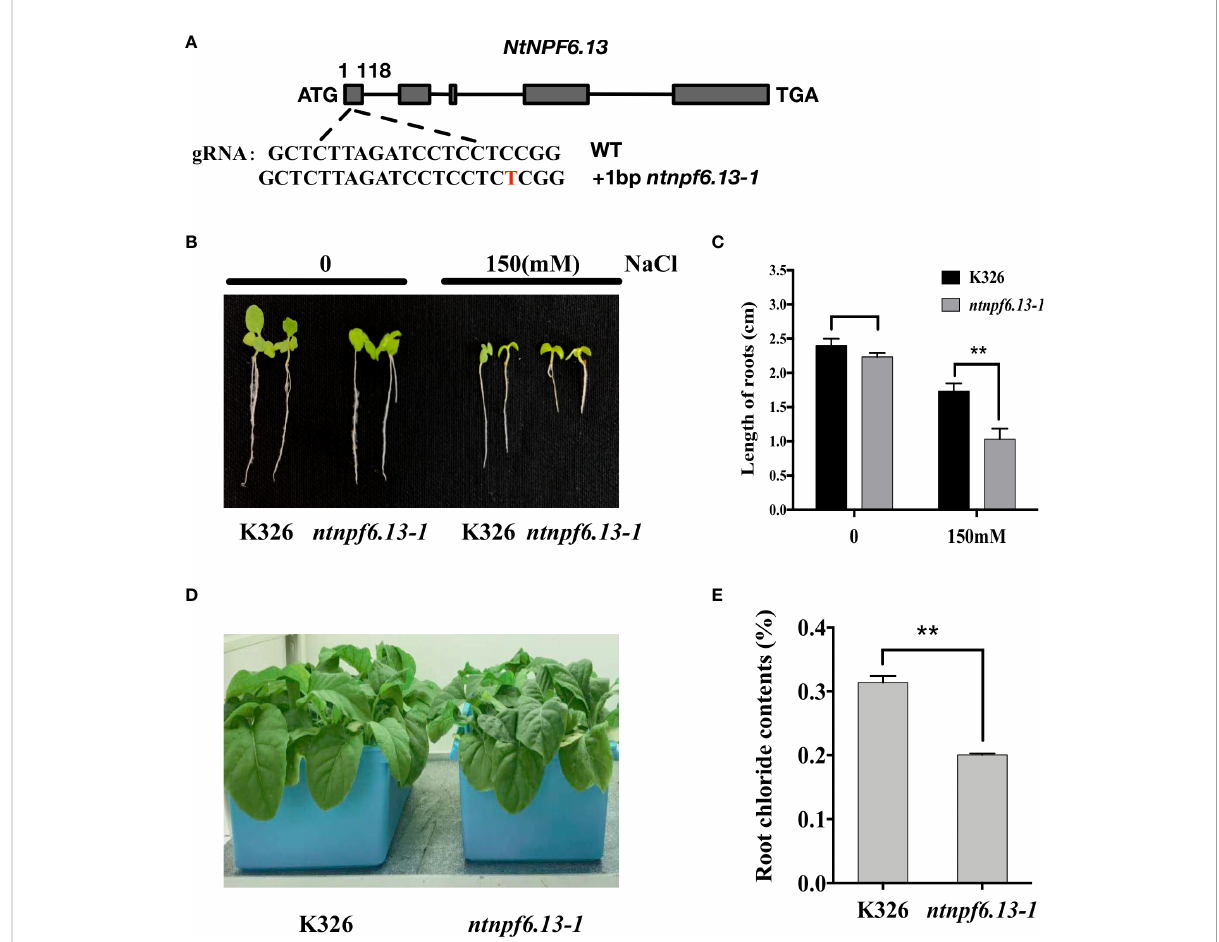
FIGURE 7 CRISPR/Cas9-mediated knockout of NtNPF6.13 reduces the Cl − content in roots of tobacco. (A) Diagram of gene structure and mutation sites of NtNPF6.13 . (B) Phenotype of ntnpf6.13-1 mutant under salt stress compared with K326. (C) Root length of ntnpf6.13-1 mutant and K326 under salt stress. The error bars and asterisks indicate the SD and statistical signi fi cance of three biological replicates (Student ’ s t -test; ** P< 0.01), respectively. (D) Hydroponic culture of ntnpf6.13-1 mutant and K326. (E) Root chloride contents of K326 and ntnpf6.13-1